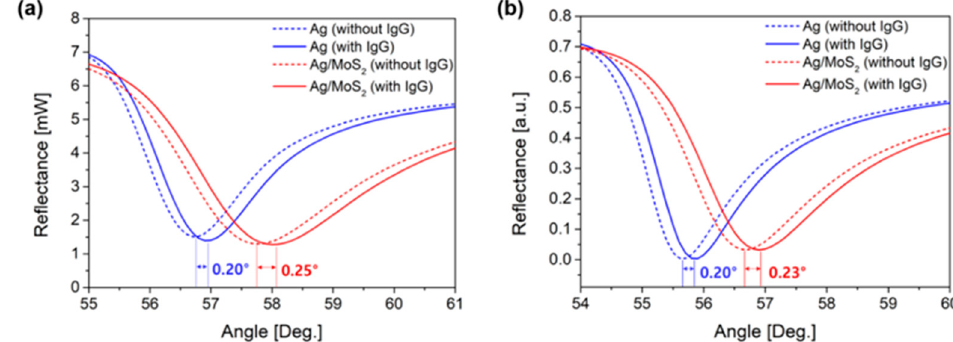
Figure 7. Experimental and simulation results of SPR signals for Ag and Ag/MoS 2 substrates for IgG detection. ( a ) SPR angle shift before and after the binding reaction of IgG of Ag substrate is 0.20 ˚ and that of the Ag/MoS 2 substrate is 0.25 ˚ . ( b ) RCWA calculation result of the SPR angle shift is 0.20 ˚ for a bare Ag substrate and 0.23 ˚ for Ag/MoS 2 substrate.